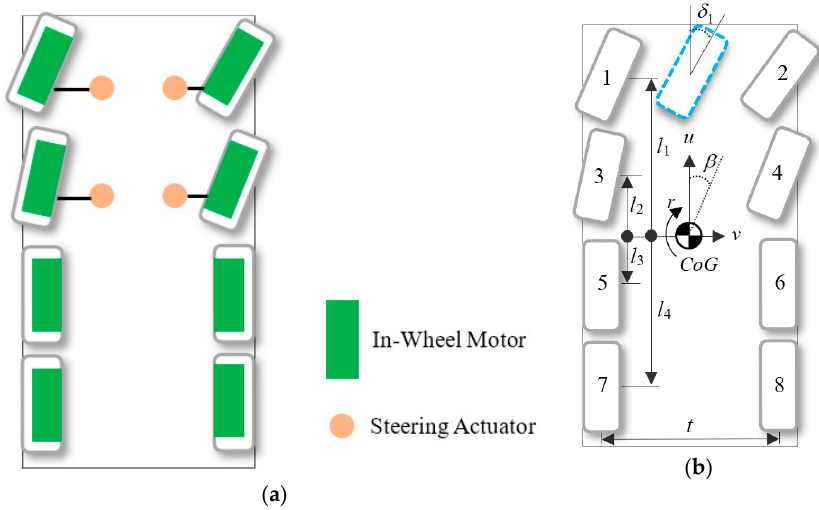
Figure 1. Vehicle model. ( a ) Vehicle layout; ( b ) vehicle parameters.